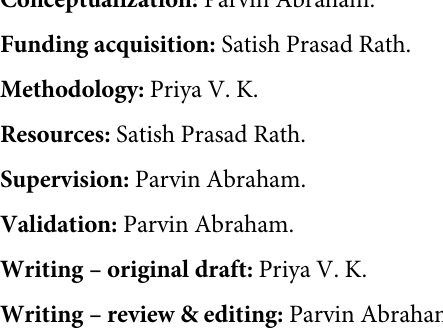
S1 Table. List of peptides that were created using the consensus sequence peptide. Bold peptides were found to be active in all the RBDs in the study. S2 Table. Interface residues of RBD that interact with Peptide 7 with the predicted hydro- gen